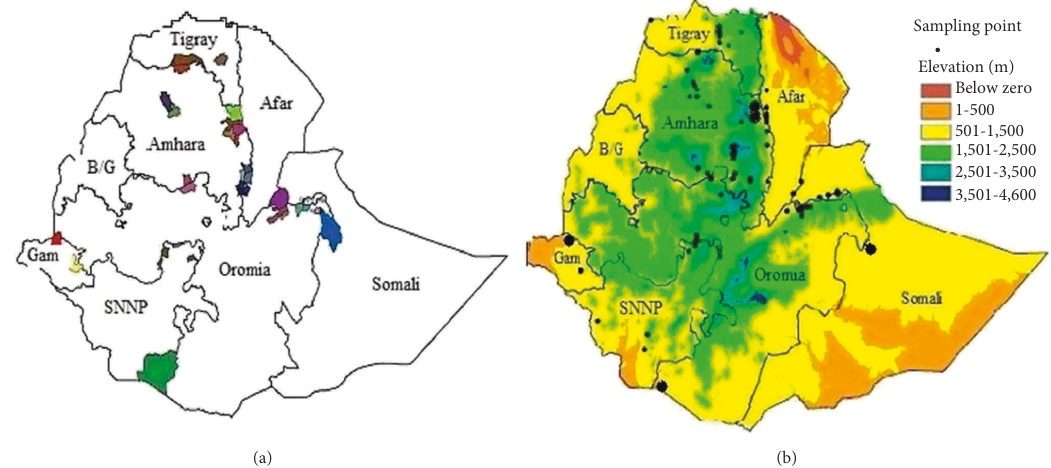
Figure 3: Spatial distribution of Ethiopian sorghum accessions. (a) Geographic distribution of geo-referenced Ethiopian sorghum ac- cessions. Color highlighted areas represent accession collection sites within regions. (b) Geographic distribution of the Ethiopian sorghum accessions along an elevation gradient. B/G (Benishangul-Gumuz); Gam, Gambella; SNNP(Southern Nations). Source: Wondimu, et al., [33].